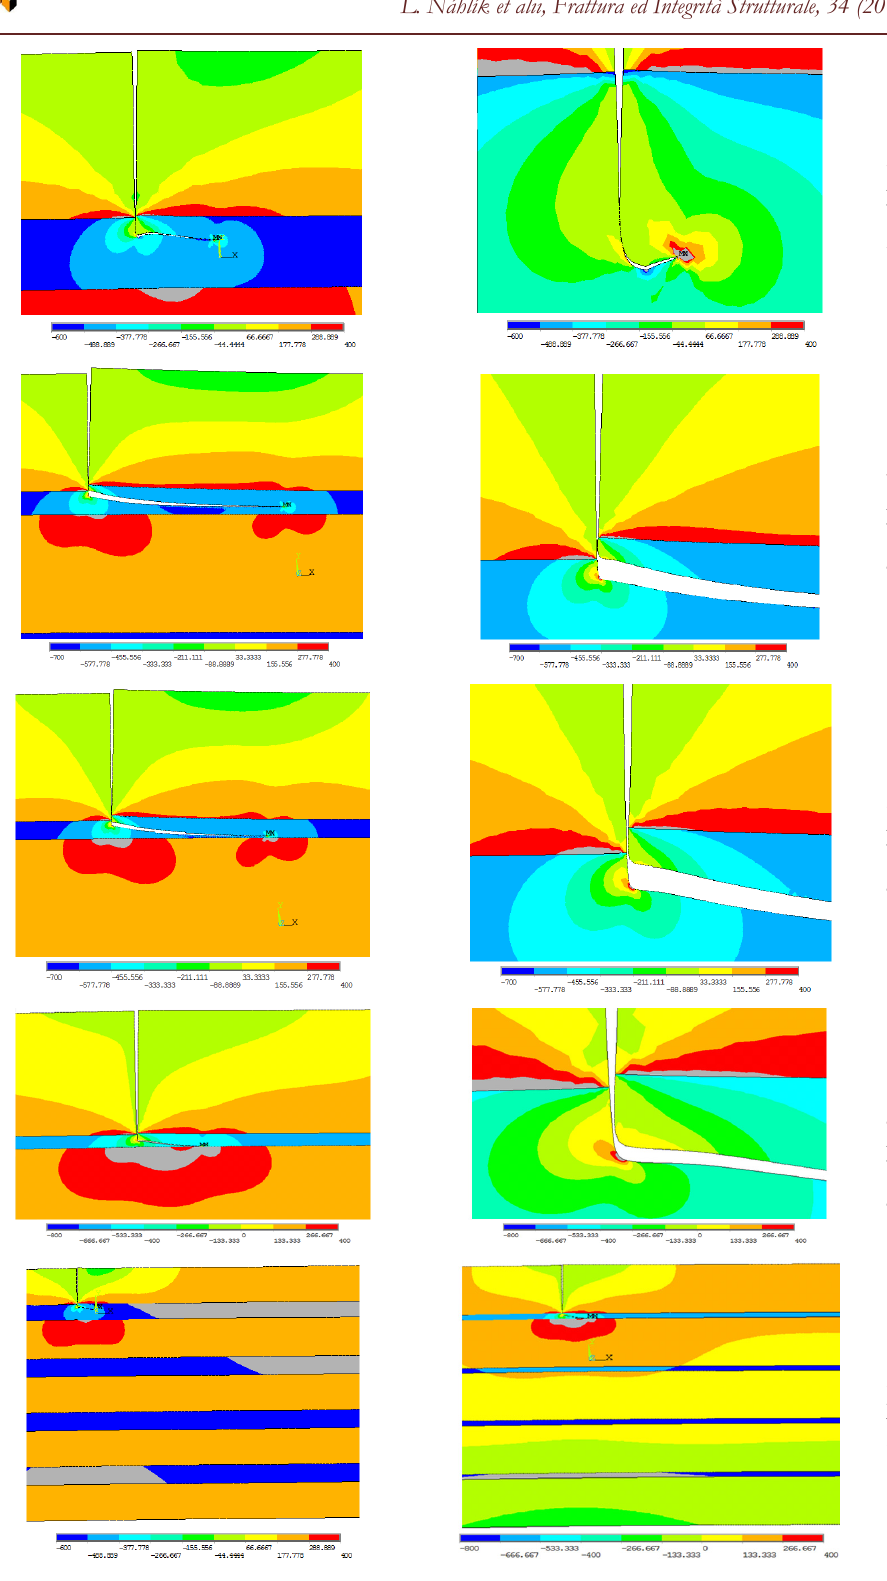
Figure 4: Simulation of crack propagation in the compressive layer for different ratio of layer thicknesses. Magnitude of longitudinal stress component is